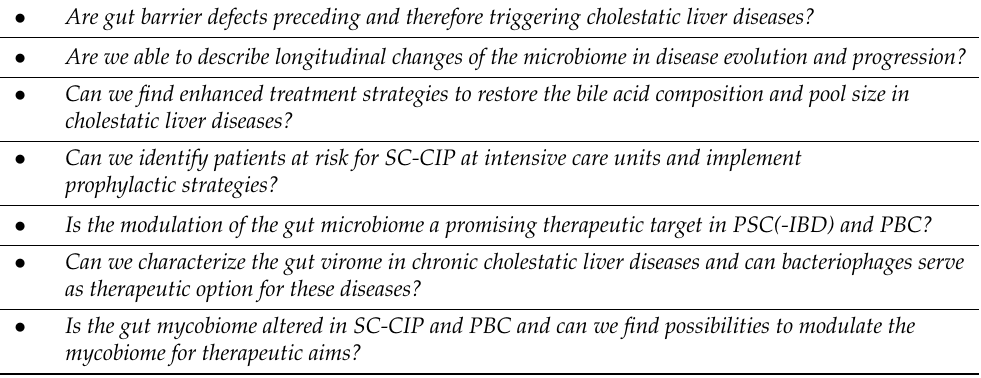
Table 4. Some future research questions concerning the gut-liver axis in chronic cholestatic liver